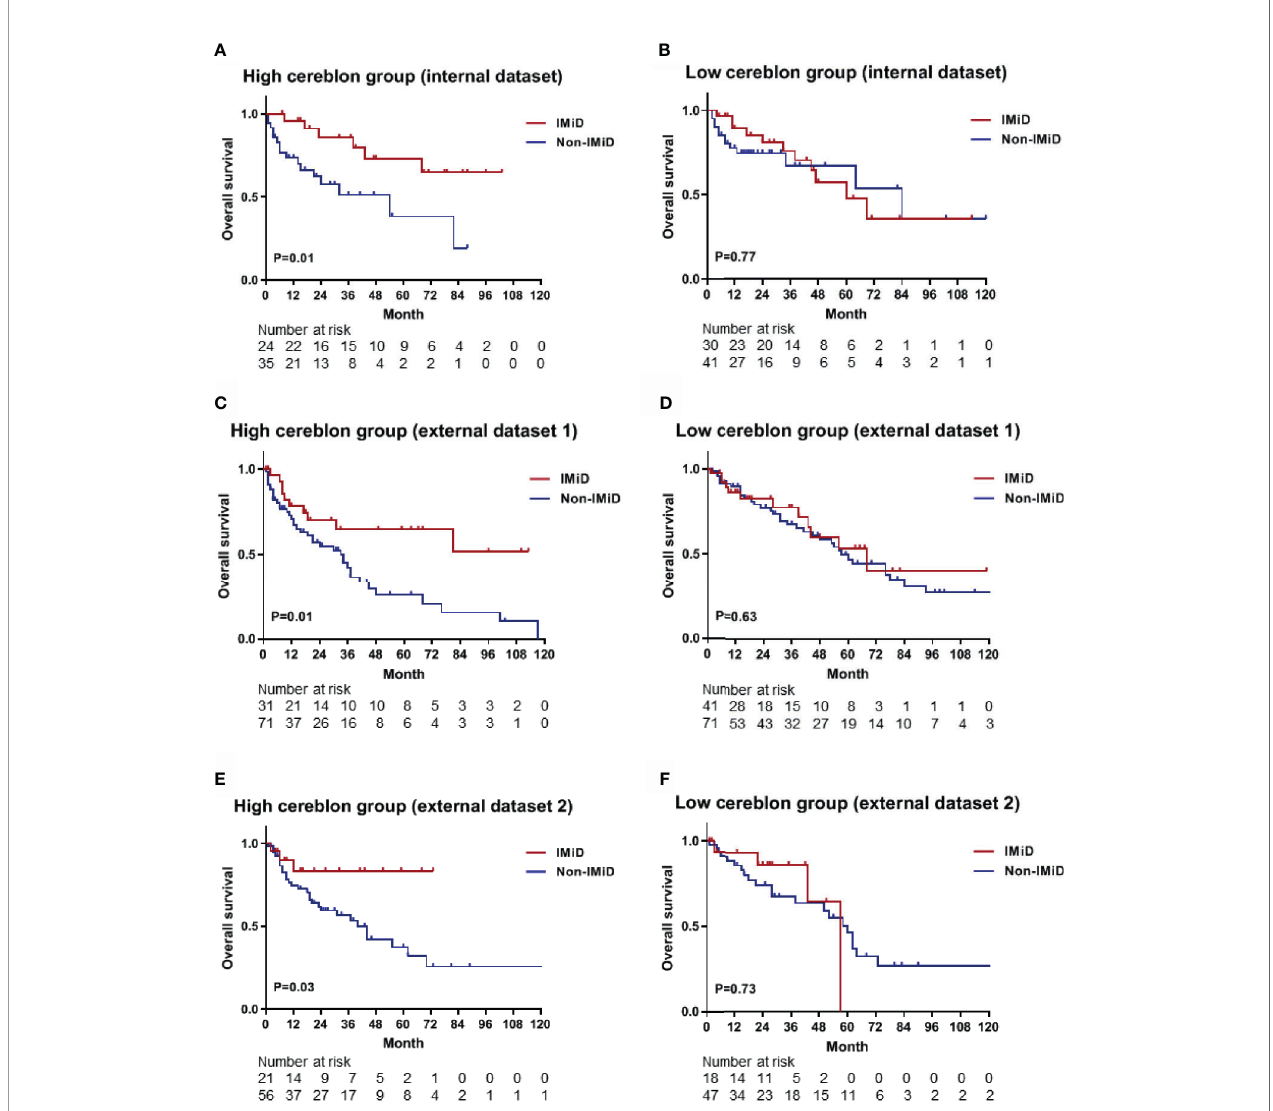
FIGURE 6 | Kaplan – Meier survival curves for OS in the high and low CRBN groups based on the CRBN prediction model. Internal dataset (data used in model development) was used for analysis and two external datasets (data from two other hospitals) were used for validation. (A) The OS curves for the high CRBN (n = 59) and (B) low CRBN (n = 71) groups from the internal dataset. The OS curves for (C) the high (n = 102) and (D) low (n = 112) CRBN groups from the external dataset 1 and for (E) the high (n = 77) and (F) low (n = 65) CRBN groups from the external dataset 2. Patients exhibiting high levels of CRBN and receiving IMiD treatment showed signi fi cantly longer OS than those receiving non-IMiD treatment. No signi fi cant differences were found between IMiD and non-IMiD treatment in the low CRBN groups. IMiD, immunomodulatory drug; OS, overall